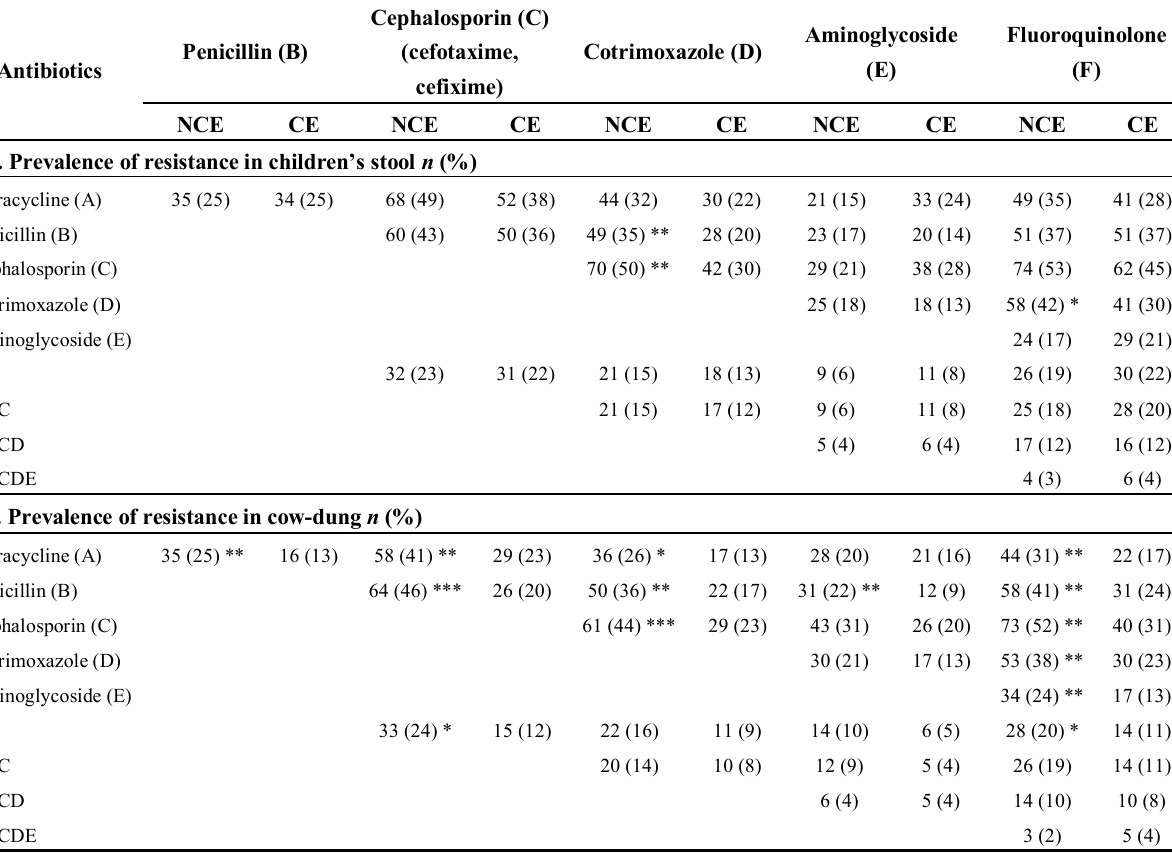
Table 4. Co-resistance and multi-resistance of E. coli in children’s stool, cow-dung and drinking water from non-coastal and coastal